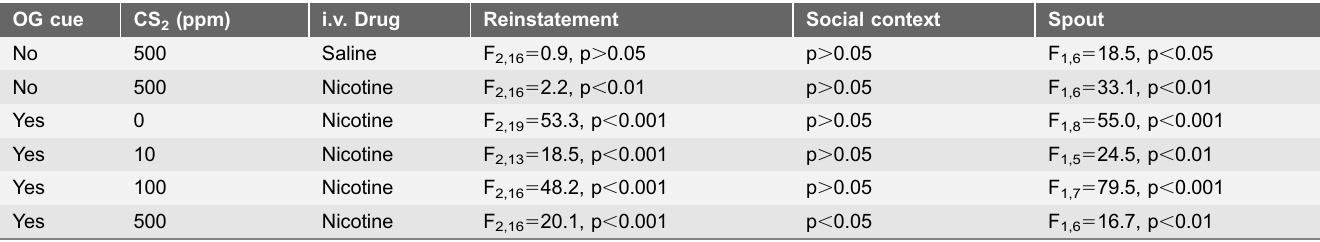
Table 1. Statistical results for context-induced reinstatement.